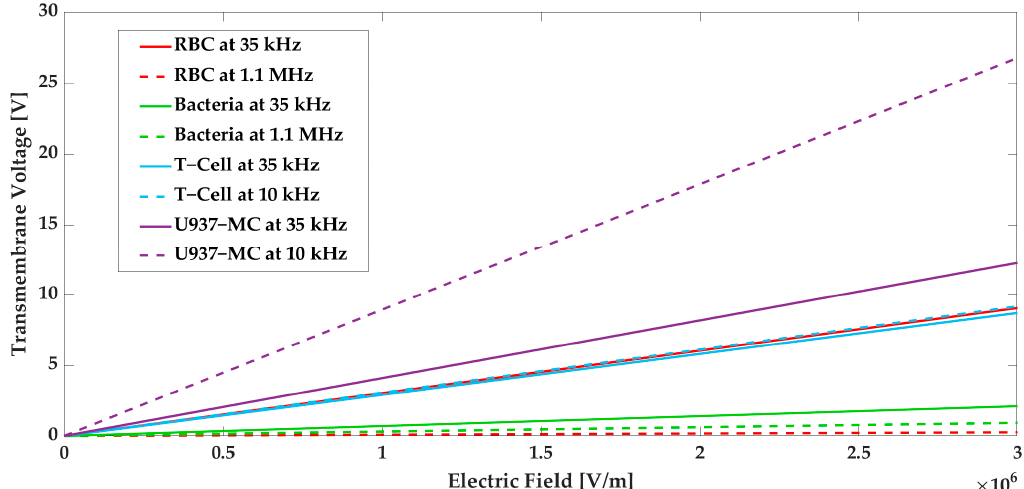
Figure 10. Transmembrane voltage for U937-MC, T-cells, RBCs, and bacteria as a function of electric fi eld.